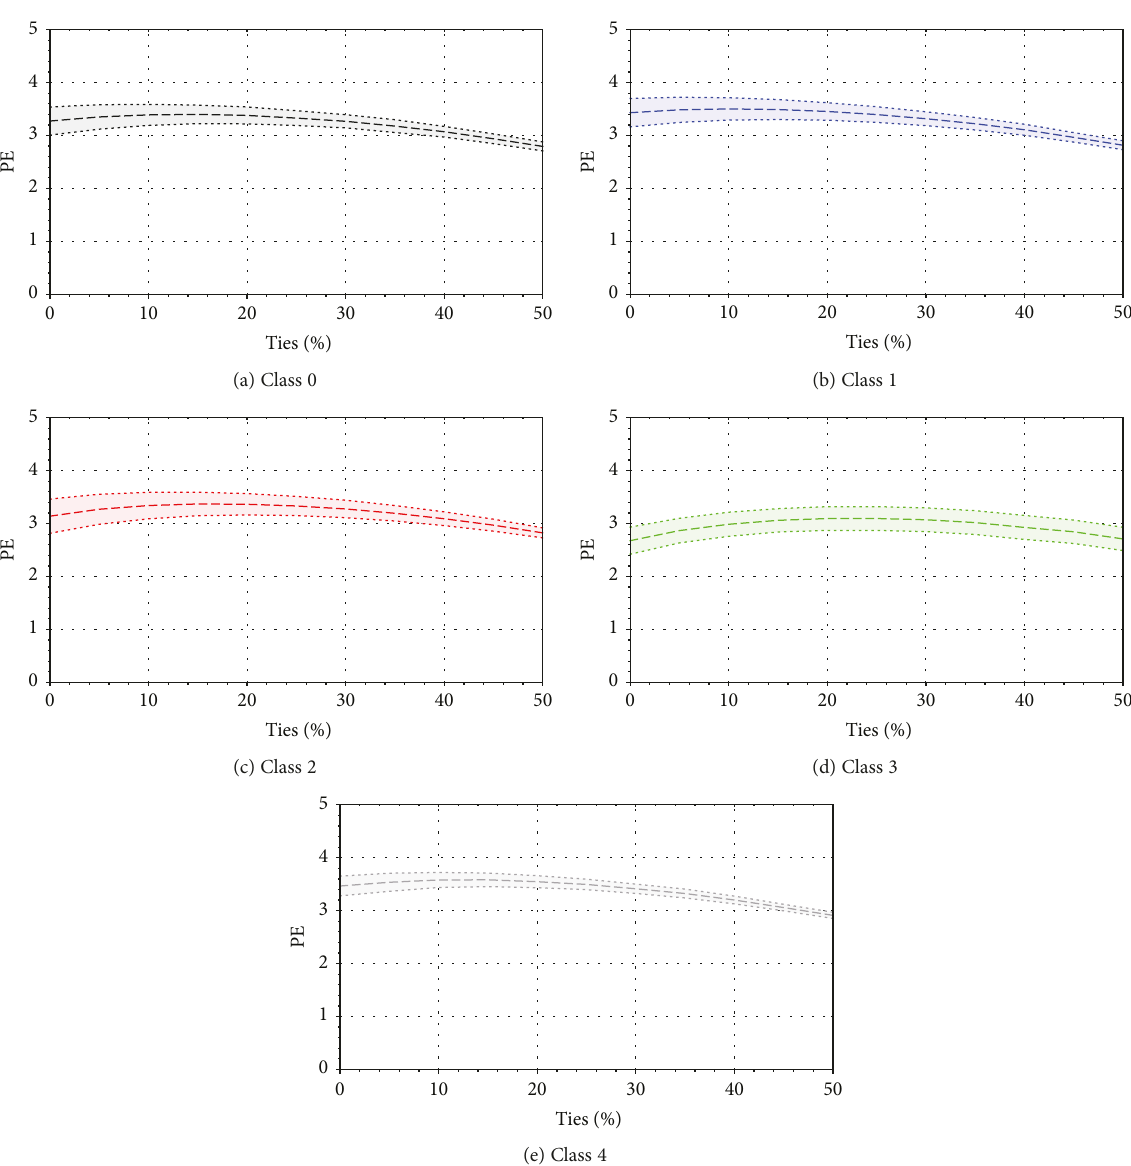
Figure 5: PE changes for variations of synthetic ties between 0% (baseline) and 50% for EEG records.